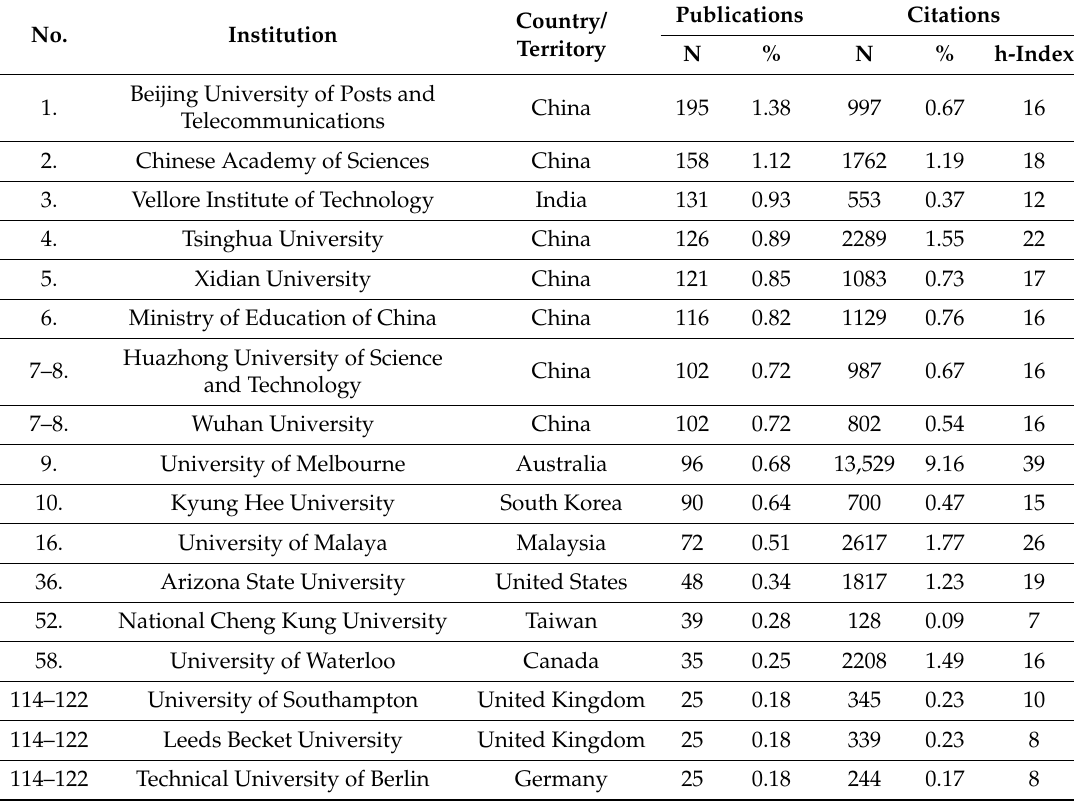
Table 2. Top most productive institutions in research on cloud